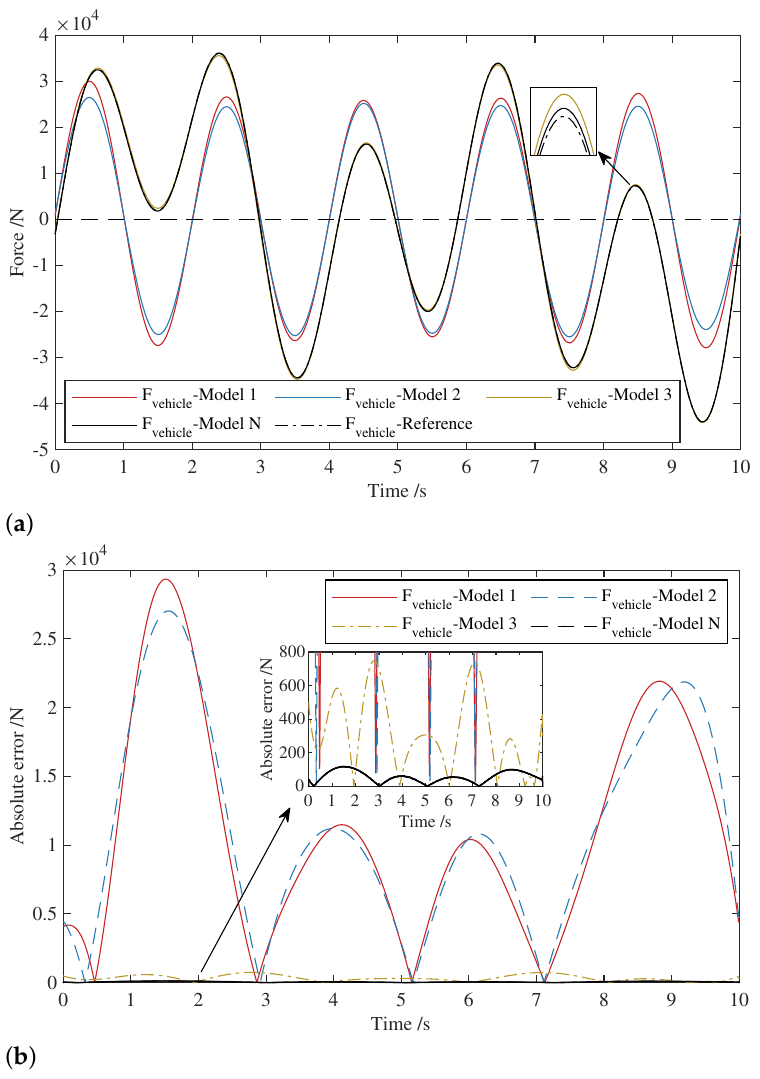
Figure 14. Comparison and error of vehicle driving force for each model. ( a ) Comparisons between calculated driving force and reference driving force of the vehicle body; ( b ) Absolute errors of calculated driving force of the vehicle